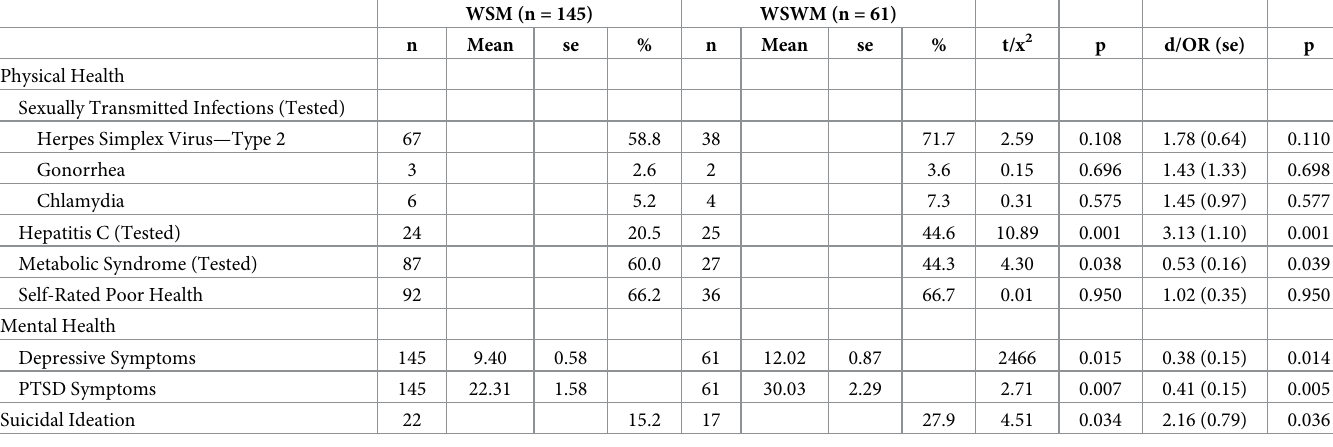
mean symptomatology, compared to WSM, for depression (d = 0.37, p = 0.015) and PTSD (d = 0.41, p = 0.008). Using the suggested clinical threshold, 72.1% of WSWM met the DSM criteria for PTSD, with 2.55 higher odds (p = 0.005) compared to WSM (50.3%). The Table 4. Differences in physical health and mental health between Women who have Sex with Men (WSM) and Women who have Sex with Women and Men (WSWM) in proyecto